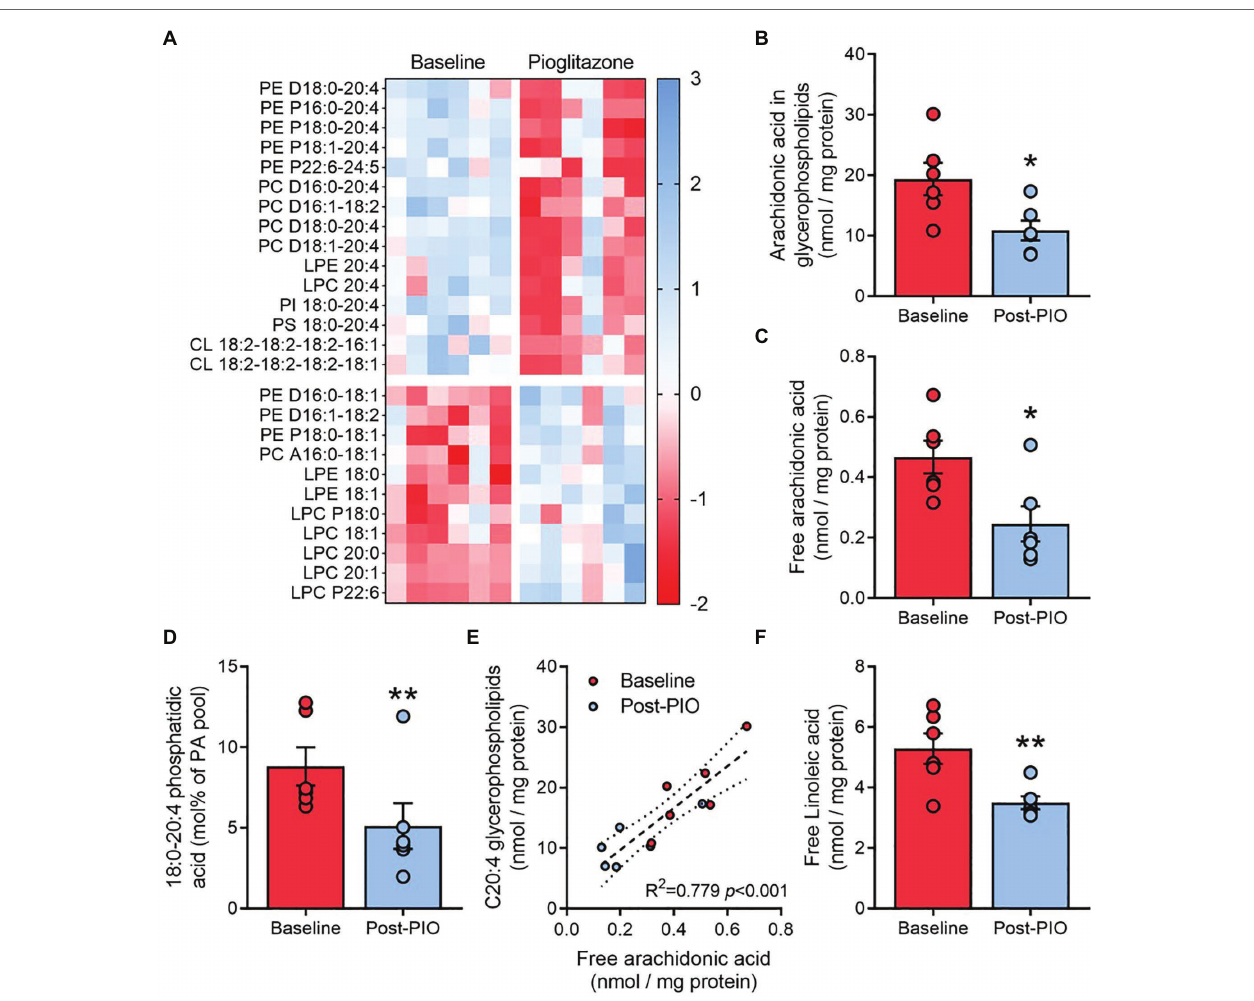
FIGURE 4 | Pioglitazone lowers arachidonic acid enrichment in adipose glycerophospholipids. Heatmap depicting fold change ( z scores) for significantly altered molecular glycerophospholipid species in paired adipose tissue samples (A) , with blue indicating an upregulation and red indicating a downregulation following 6 months of 45 mg/day pioglitazone treatment. Lipids were first normalized to total glycerophospholipid content detected in each respective sample and compared with multiple paired t tests corrected for a false discovery rate of 10%. Absolute content of arachidonic acid esterified in glycerophospholipids (B) and in unesterified form (C) , and its fractional contribution in phosphatidic acid (D) , as well as the correlation between free and glycerophospholipid esterified arachidonic acid (E) and absolute content of linoleic acid (F) in paired adipose tissue samples at Baseline (red) and Post-PIO (blue). * p < 0.05, ** p < 0.01 vs. Baseline. Data are mean ± standard error (filled bars) and individual values (filled circles) for n = 6